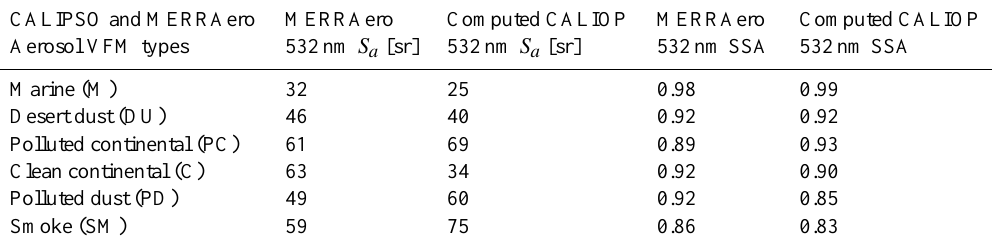
Table 3. MERRAero-Extinction and Mie theory computed CALIOP 532 lidar ratio ( S a ) and single-scattering albedo (SSA) for each VFM aerosol